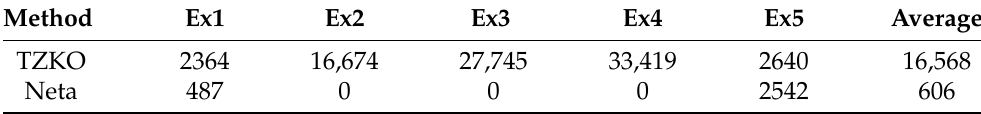
Table 4. Number of black points for each example (1–5) and each of the